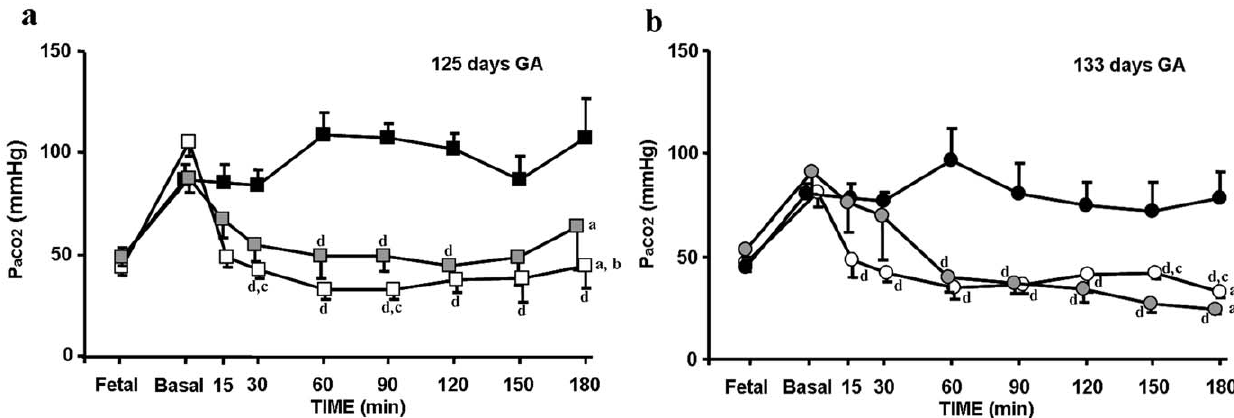
Figure 2. Mean arterial Pa CO2 in premature lambs at two gestational ages. Mean arterial Pa CO2 (a) at 125 days of GA in Control-125d [indicated by black squares]; surfactant, SF-125d [indicated by grey squares]; and partial liquid ventilation, PLV-125d [indicated by white squares] groups. Mean Pa CO2 (b) at 133 days of GA in Control-133d [indicated by black circles]; surfactant, SF-133d [indicated by grey circles]; and partial liquid ventilation, PLV-133d [indicated by white circles] groups. Fetal: indicates the fetal values in both groups, while the lambs are still connected to the placenta. Baseline: shows pre-treatment values before pulmonary treatment. Values are given as mean 6 SEM. Significant differences are indicated by: ( a ) vs. Control group, P , 0.05, two-way ANOVA over all time points; ( b ) vs. SF group, P , 0.05, two-way ANOVA over all time point; ( c ) vs. SF group, P , 0.05, one-way ANOVA at each time point; and ( d ) vs. Control group, P , 0.05, one-way ANOVA at each time point.